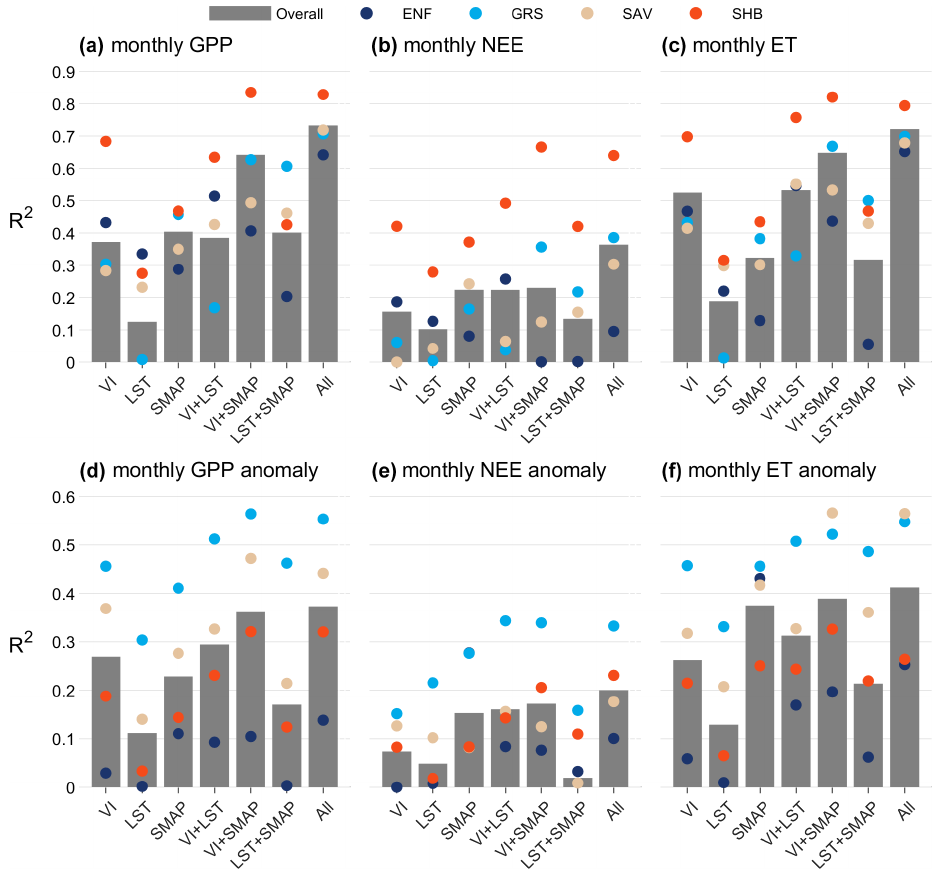
Figure 8. Coefficient of determination ( R 2 ) for models based on different combinations of predictor variables: optical VIs, MODIS LST, and SMAP soil moisture and temperature. Gray bars show overall model R 2 (across all sites), while colored dots show model R 2 across all sites of a given vegetation type. (a–c) DrylANNd model performance for predicting observed monthly fluxes across all 28 eddy covariance sites. (d–f) DrylANNd model performance for predicting monthly flux anomalies relative to monthly site means across the 16 eddy covariance sites that cover the full study period (2015–2020). For purposes of calculating monthly site means, missing monthly data were filled with a spline interpolation after which mean fluxes were calculated for each month during the 2015–2020 study